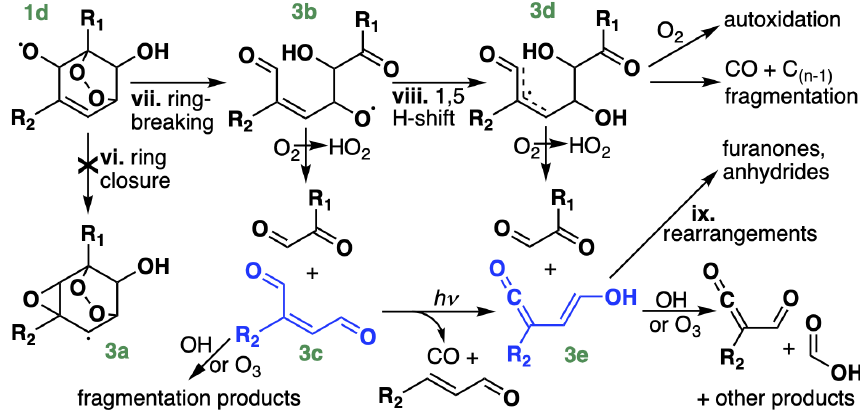
Figure 3. Chemical pathways following OH addition to BTX, continued from Fig. 1. R 1 and R 2 denote either H or CH 3 , depending on the species. For toluene and xylene, only OH addition ortho to R 1 is shown, and for xylene, only the meta isomer is shown; isomeric differences could lead to differing placement of R 1 and R 2 on the stable products, including the formation of acetic rather than formic acid (bottom right). Compounds in blue (Fig. 3c and 3e) are treated as lumped stable intermediates in